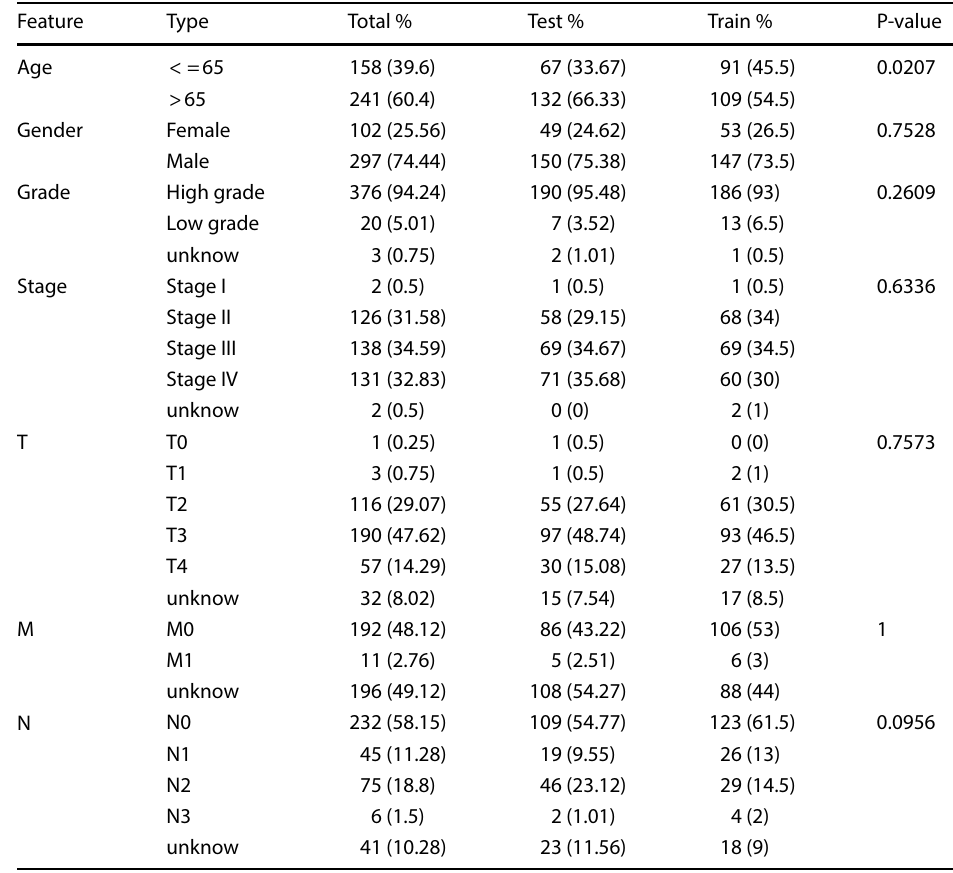
Table 2 Clinical characteristics of bladder cancer patients in TCGA